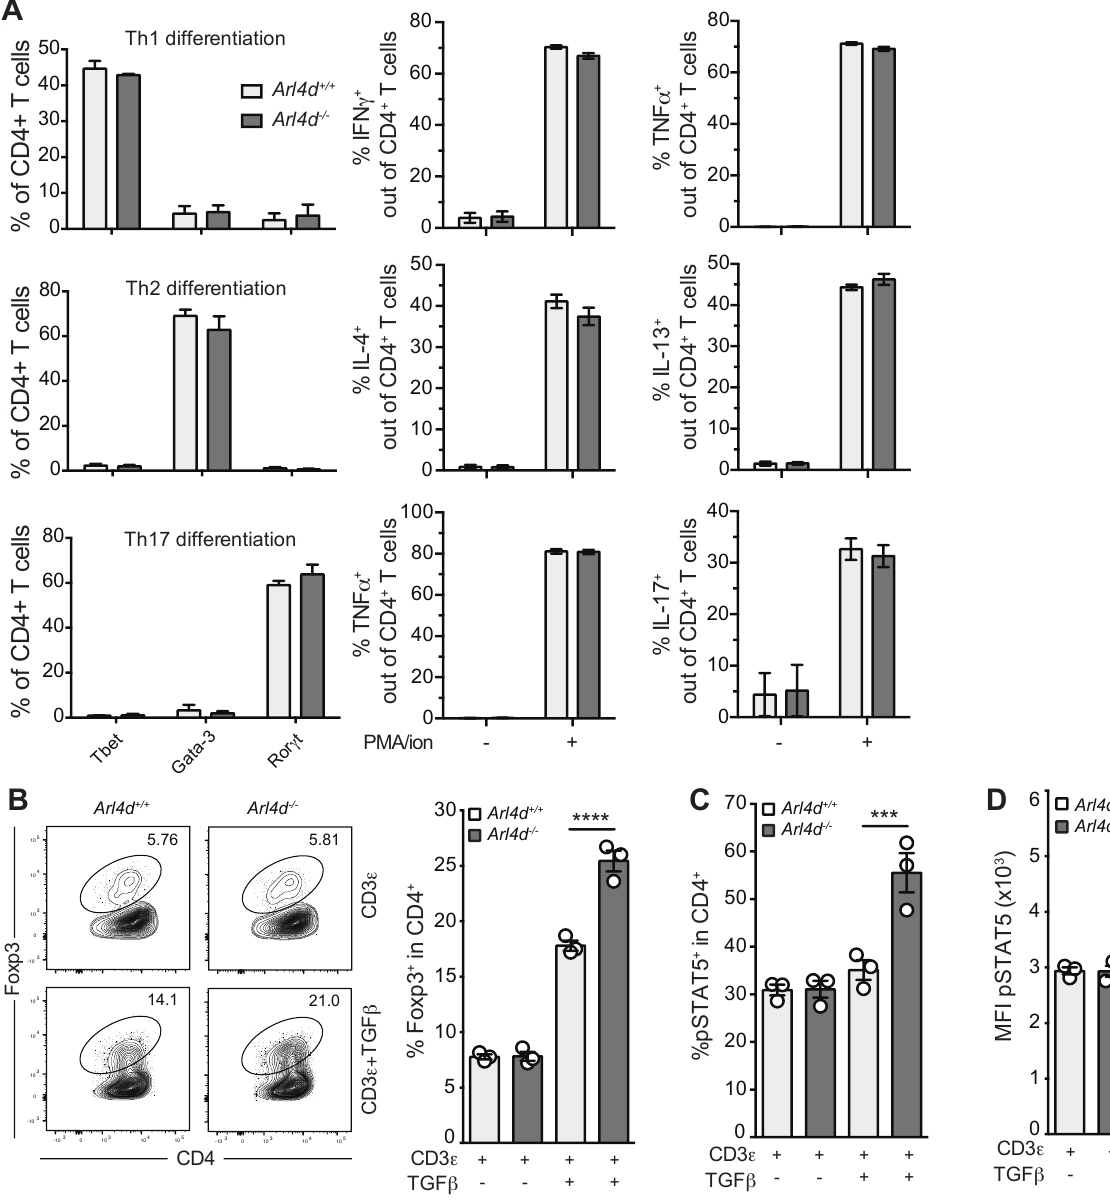
+ + ++ + + ++ + - - - - + Figure 3. Arl4d controls regulatory T-cell conversion. ( A ) Arl4d +/+ or Arl4d − / − splenic CD4 + T cells were differentiated into T H 1, T H 2, or T H 17 cells using a commercial kit. After differentiation, CD4 T cells were stained intracellularly for the signature transcription factors T-bet (T H 1), Gata-3 (T H 2), and Ror γ t (T H 17). Additionally, CD4 + T cells were stimulated with PMA and ionomycin and stained intracellularly for the following cytokines: T H 1: IFN γ and TNF α ; T H 2: IL-4 and IL-13; T H 17: TNF α and IL-17. Bar graphs show the percentages of transcription-factor- or cytokine-expressing cells within the CD4 + T-cell population. ( B – D ) Arl4d +/+ or Arl4d − / − splenic CD4 + T cells were stimulated with plate-bound α CD3 ε (1 µ g/mL) in the presence or absence mTGF β (8 ng/mL) for 48 h, after which cells and supernatants were harvested and analyzed by flow cytometry and ELISA. ( B ) Representative dot plots of T reg induction. Populations shown are gated on viable CD4 + cells. Bar graph also shows the percentage of Foxp3 + cells within the CD4 + T-cell population. ( C ) The percentage of pSTAT5 + cells within the CD4 + T-cell population. ( D ) MFI of pSTAT5 in pSTAT5 + CD4 T cells. Representative data of two ( A ) or three ( B – D ) experiments. Statistical significance was determined by Student’s t test, n.s.: not significant *** p ≤ 0.001, **** p ≤